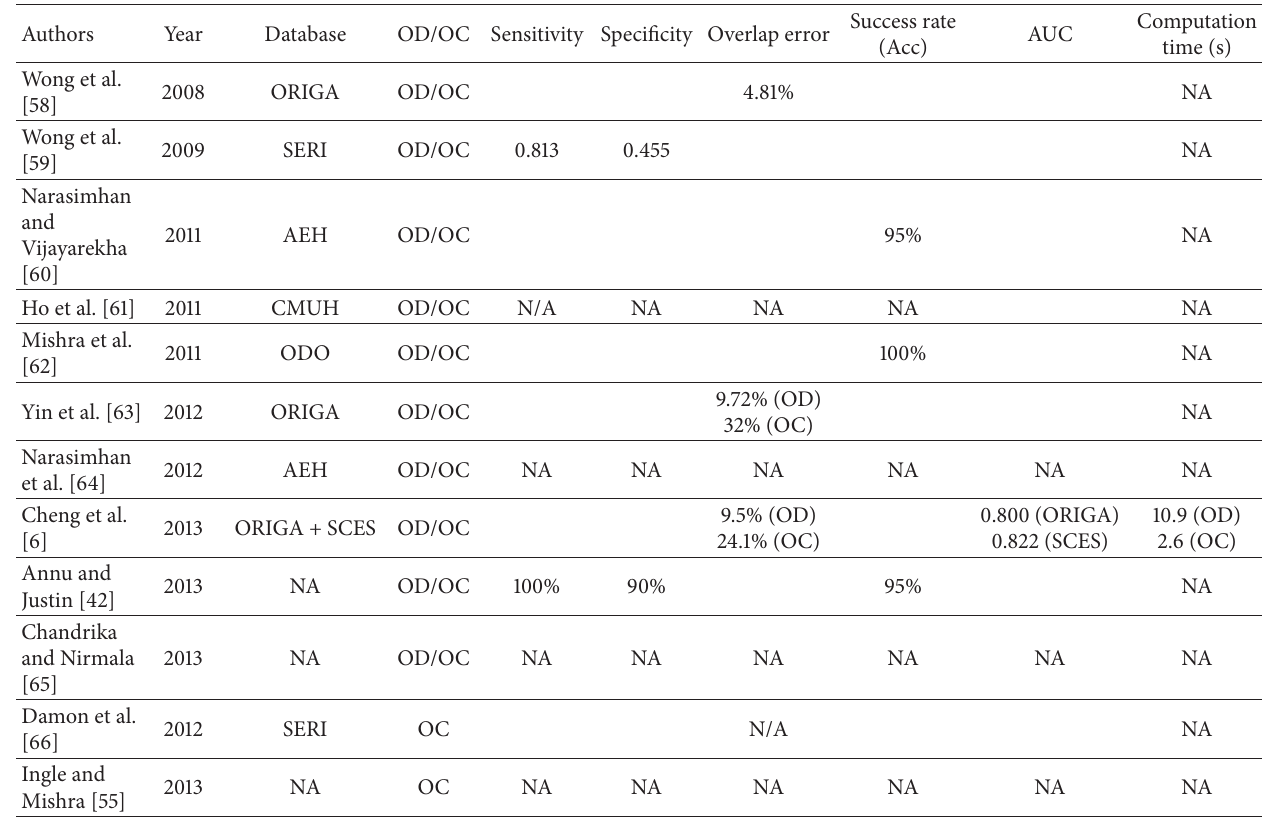
Table 5: Performance results for the optic disc and optic cup